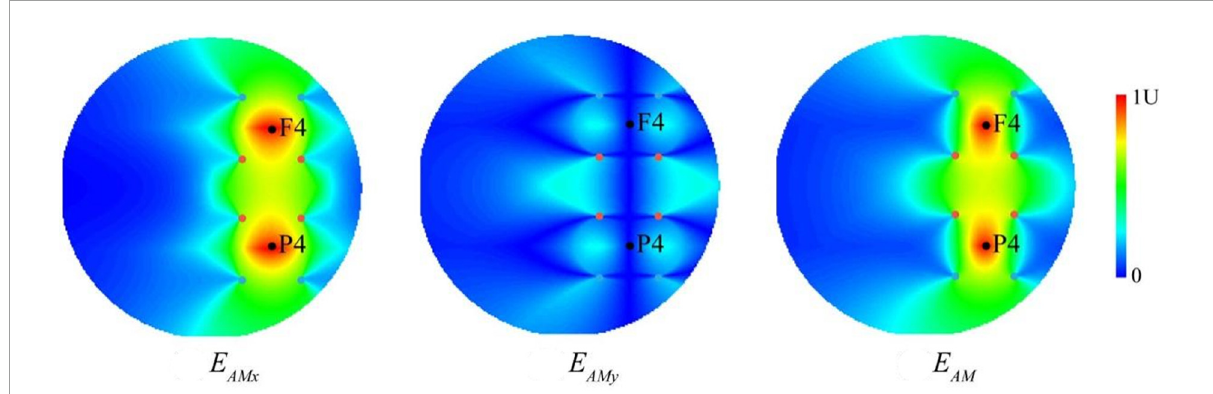
FIGURE3 The computational modeling of temporal interference (TI). The envelope modulation amplitude distribution of temporally interfering electric field projected along x - and y -directions (EAMx and EAMy) as well as the combined electric field (EAM). The two black dots represent the F4 and P4 positions of the EEG cap, respectively, and the four sets of colored dots represent the electrode positions of two TI electric fields (i.e., two pairs of two alternating currents with the frequencies of 2,000 and 2,006 Hz), corresponding to those in Figure 2 . Values are normalized to the